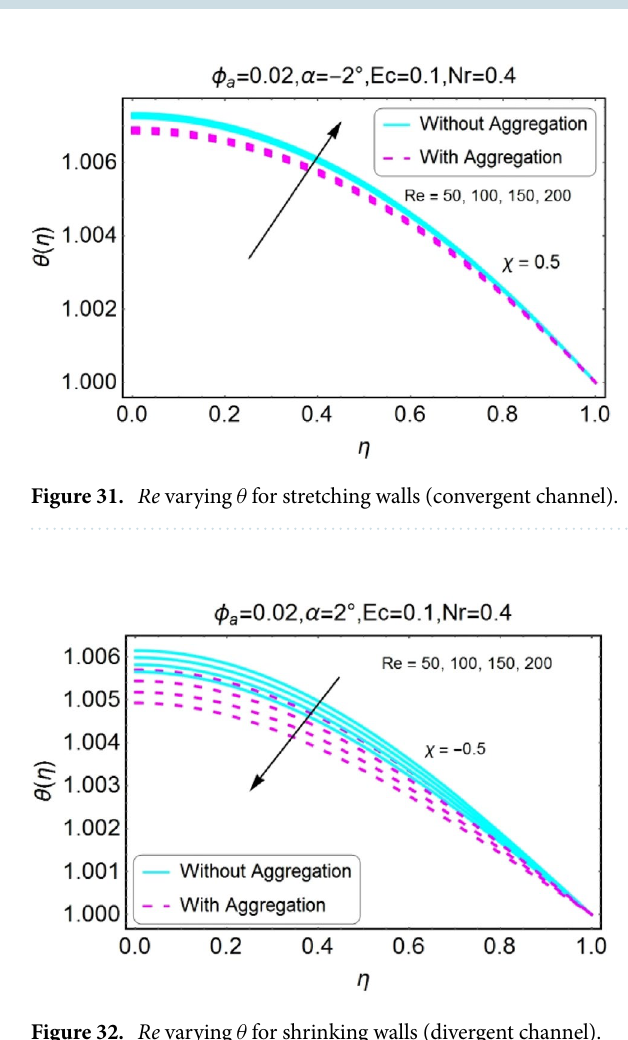
Figure 32. Re varying θ for shrinking walls (divergent channel).